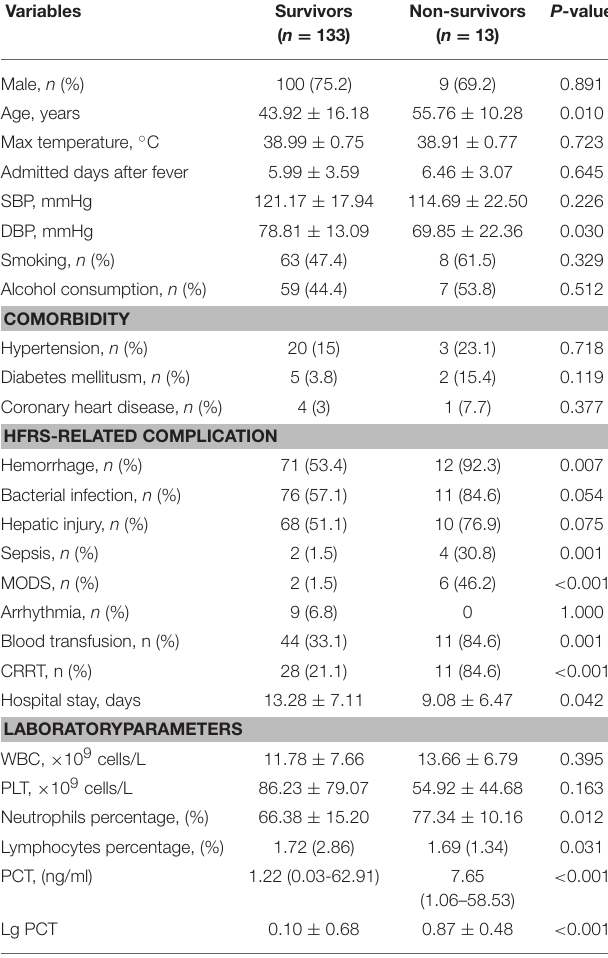
TABLE 6 | Demographics, clinical data and laboratory perameter at admission in survivors and non-survivors of patients with HFRS.